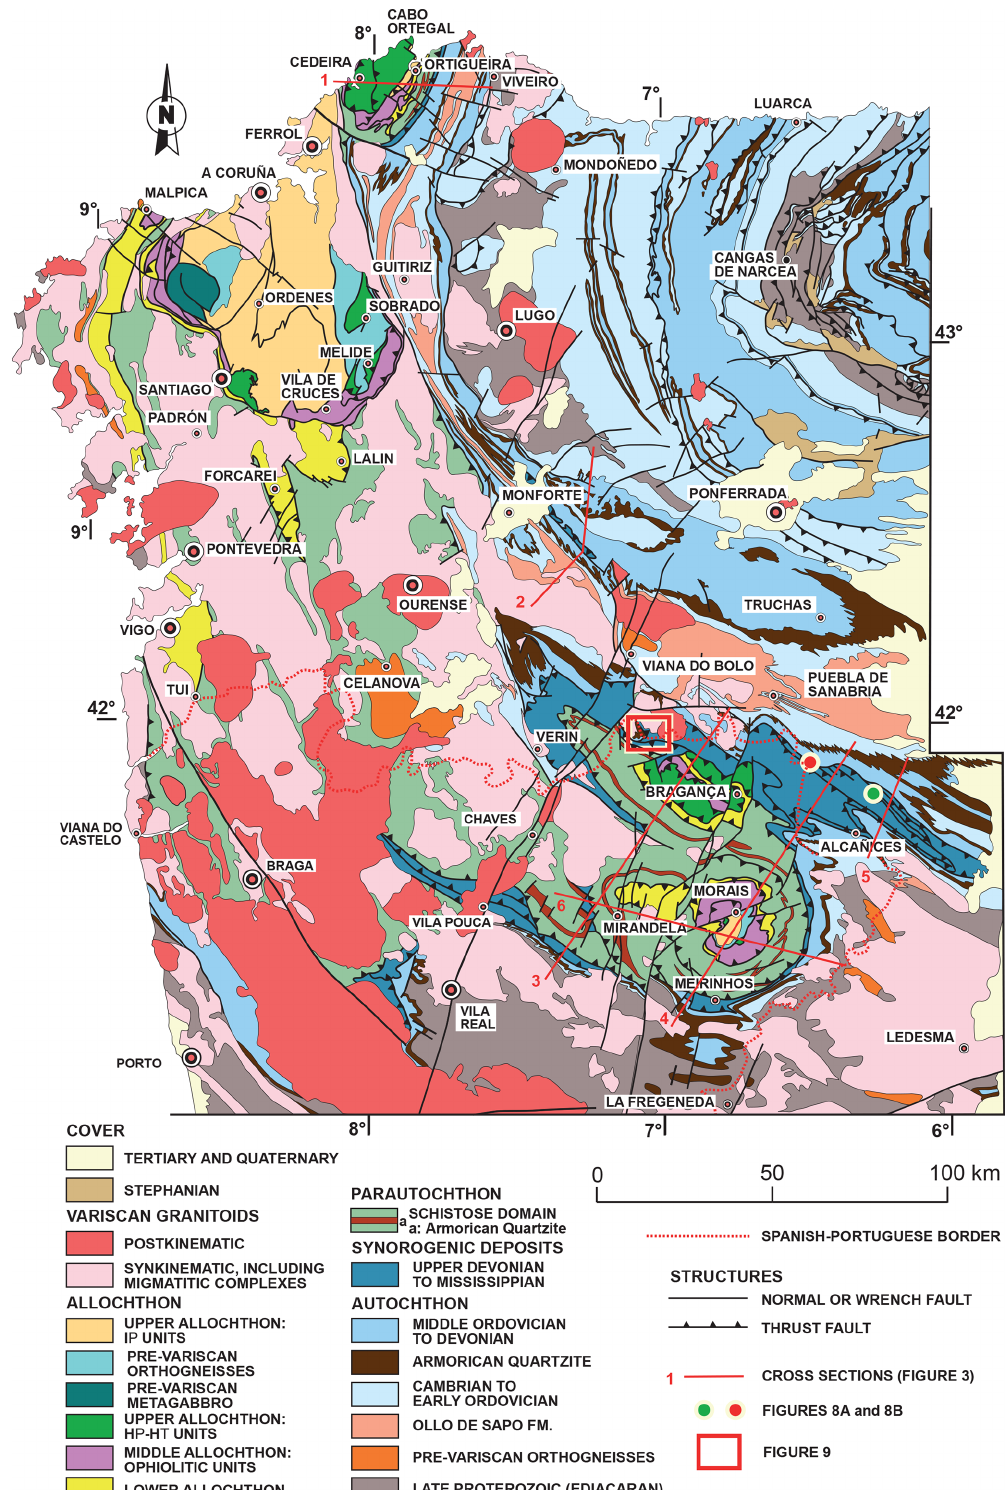
Figure 2. Simplified geological map of the NW Iberian Variscan Massif modified from Martínez Catalán et al. (1997). The limits between Lower Allochthon, Upper and Lower Parautochthon, and the autochthonous unit have been modified according to this